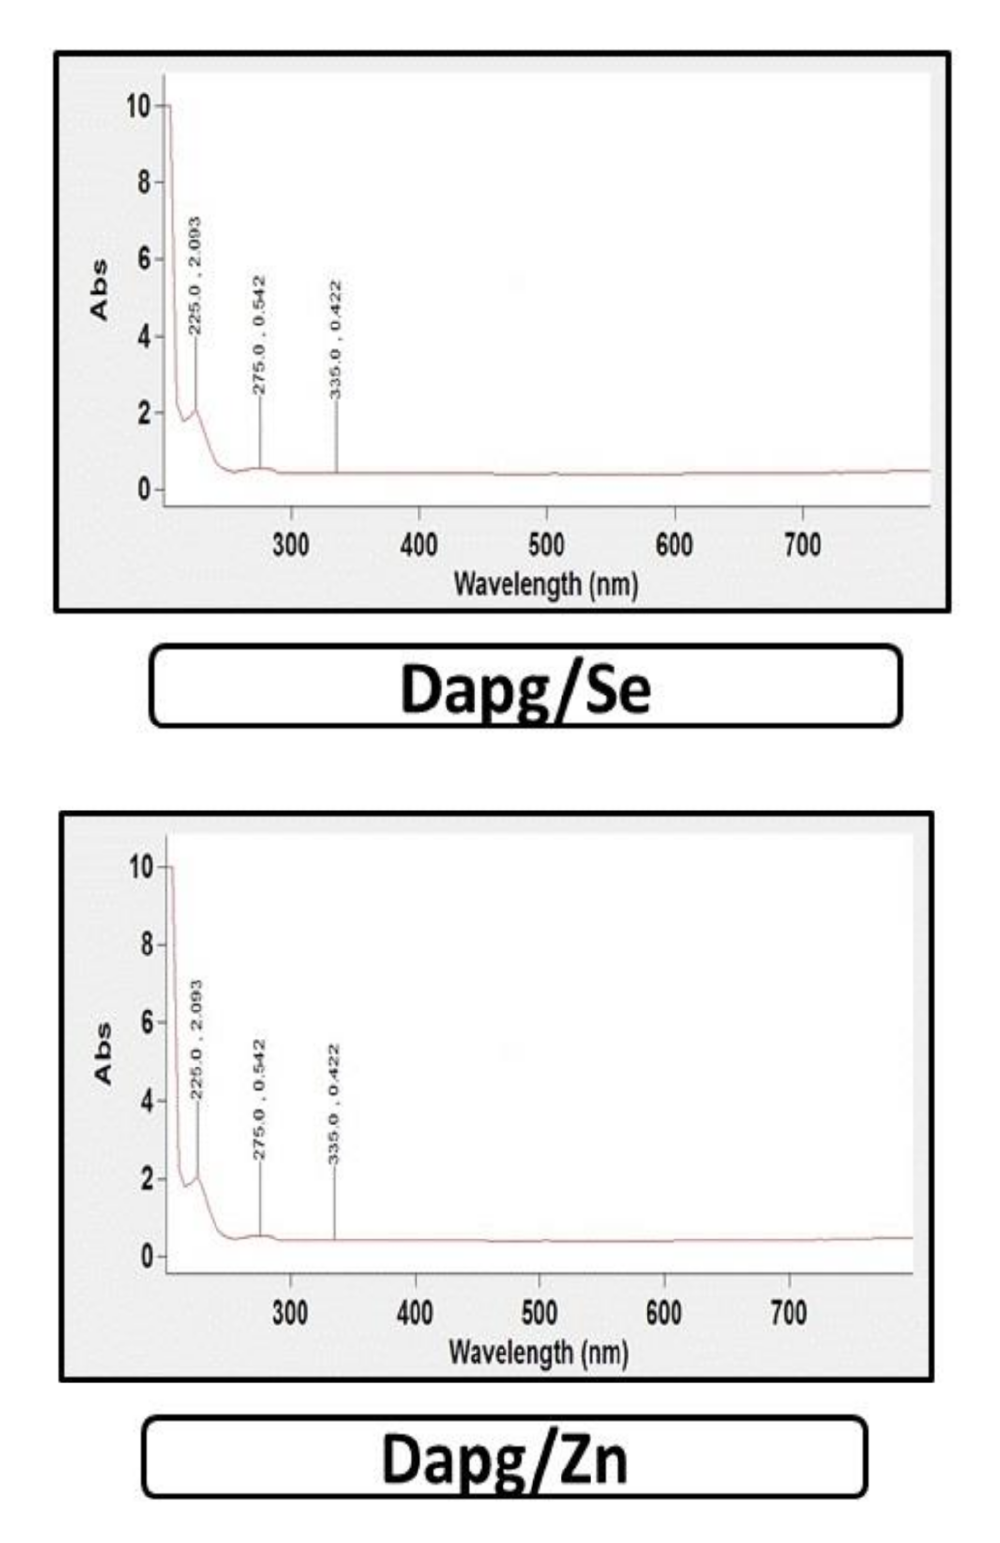
Figure 4. UV of Dapg, Cr–Dapg, Zn–Dapg and